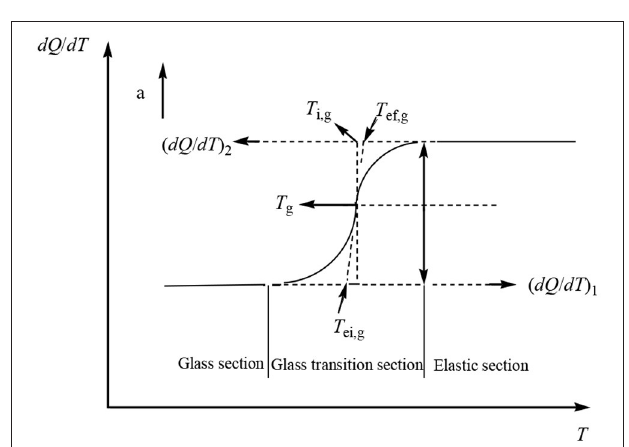
FIGURE 7 | The schematic diagram of glass transition in DSC testing